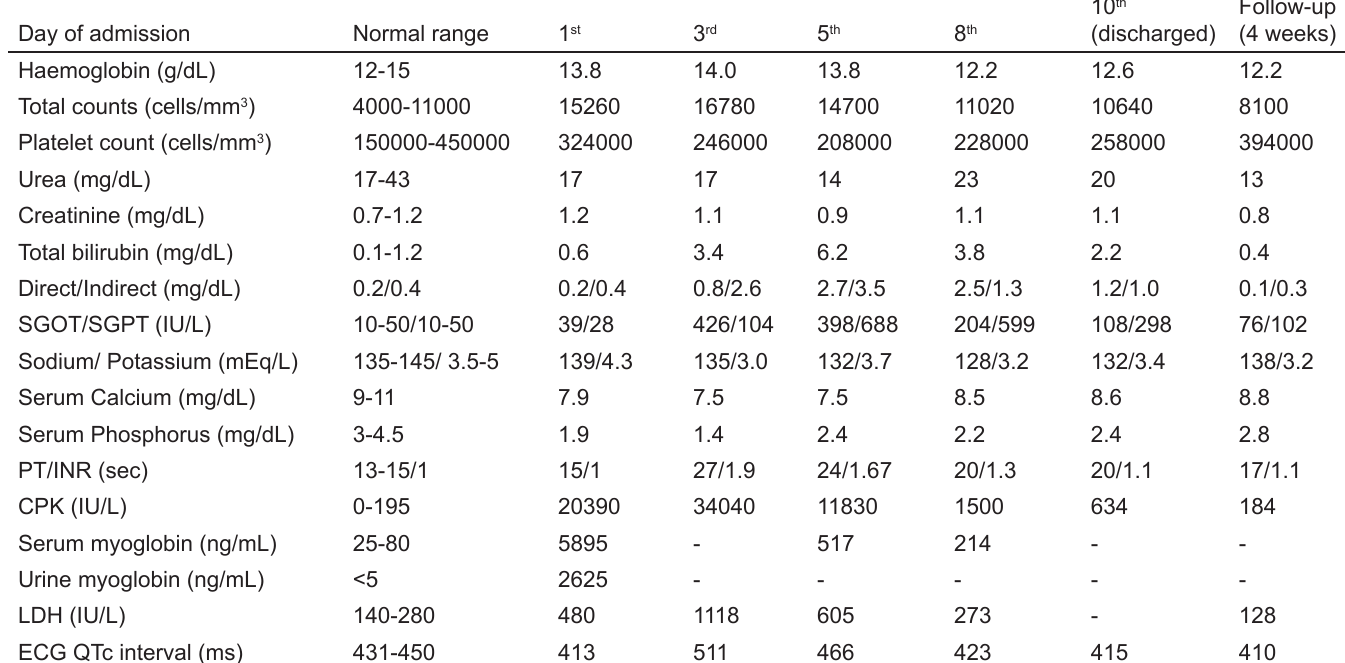
Table . Laboratory parameters in a patient with chloroform toxicity.